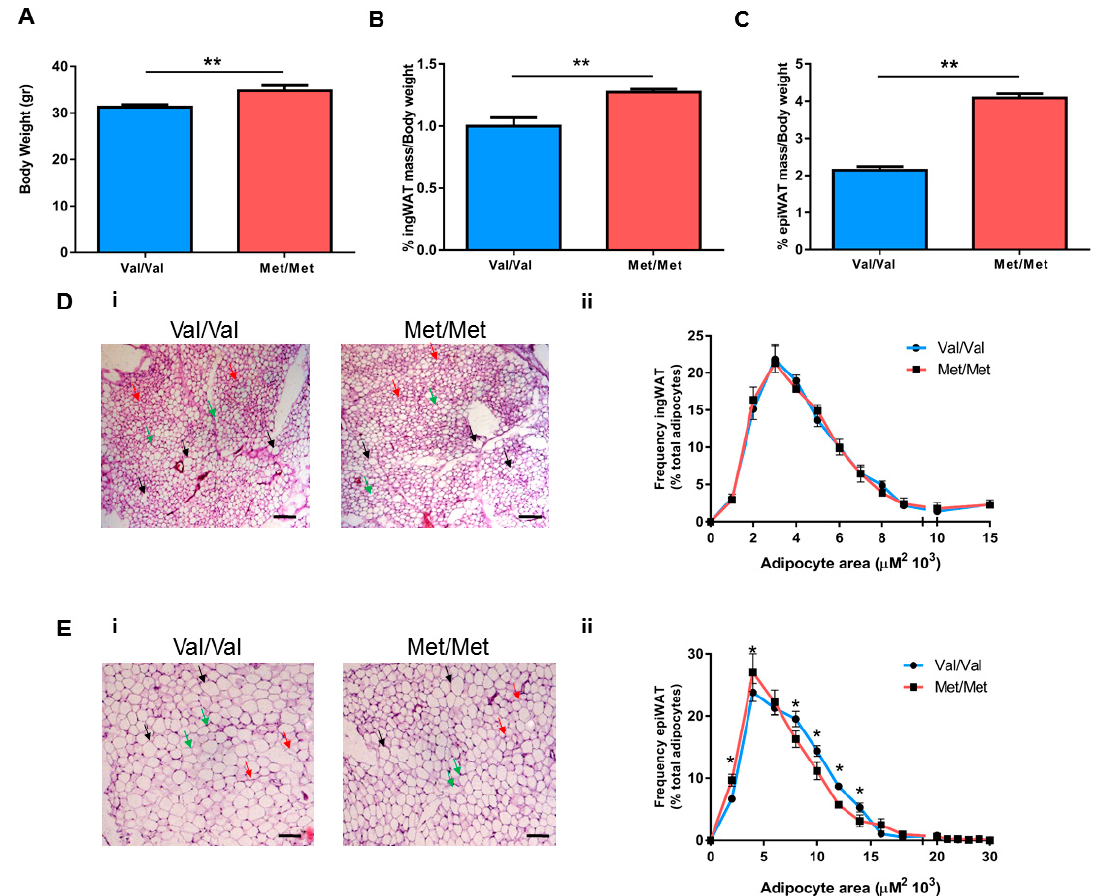
Figure 1. Characterization of white adipose tissue depots in BDNF Val / Val and BDNF Met / Met mice. ( A ) Body weight, percentage of ( B ) inguinal (ingWAT) and ( C ) epidydimal (epiWAT) white adipose tissue on total mouse body weight. (i) Representative hematoxylin and eosin (H&E) staining images and (ii) analysis of the frequency distribution of adipocyte sizes in ( D ) ingWAT and ( E ) epiWAT. Size bar: 100 µ m. Black arrow: large adipocytes, green arrow: medium adipocytes, and red arrow: small adipocytes. Data are expressed as mean ± SEM. n = 6 mice / group. ( A – C ) Student’s t-test and ( D , E ) two-way ANOVA followed by Bonferroni post hoc analysis. * p < 0.05, ** p < 0.01.